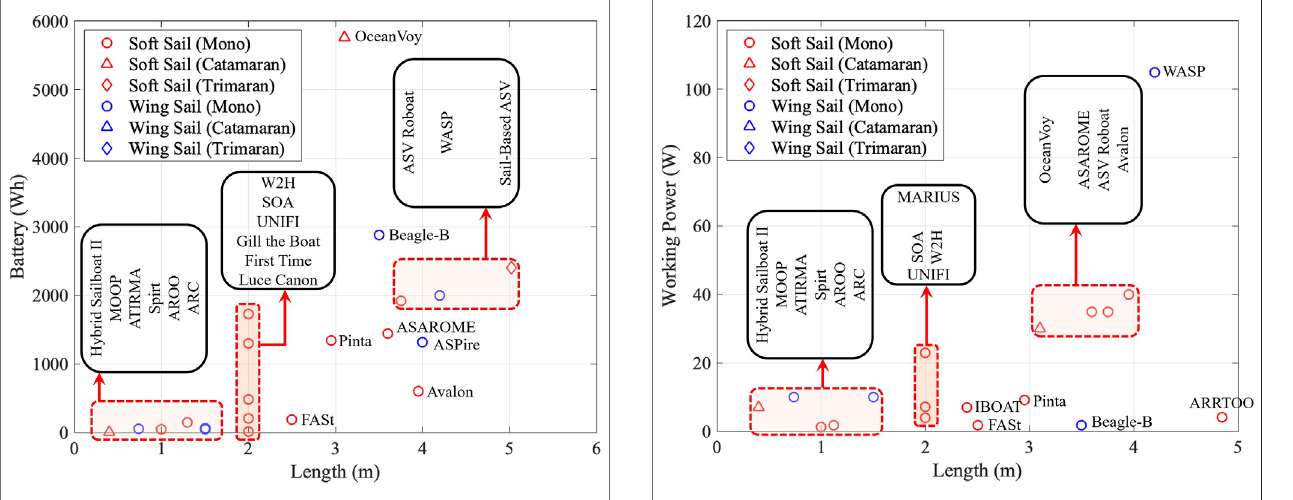
FIGURE 9 | Correlation between sailboat length and battery capacity. FIGURE 10 | Correlation between sailboat length and working